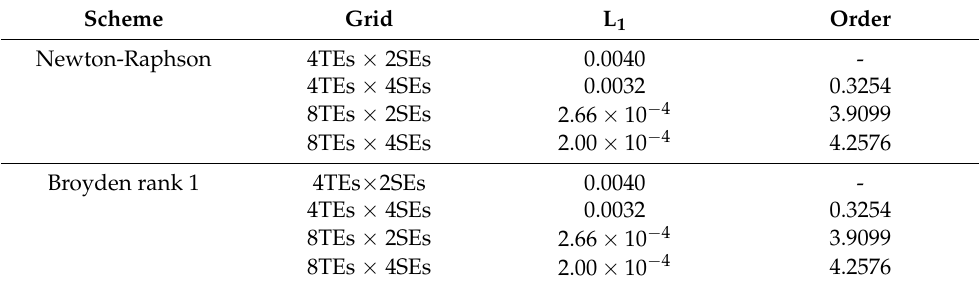
Figure 6. ( a ) The spending time by calculation in part A and part B of Equation (32). ( b ) Total spending times in different examples. ( c ) The average iteration times during calculation in different examples. ( d ) The residual error in different examples. Table 6. Grid refinement test for the double-end impact on different grid